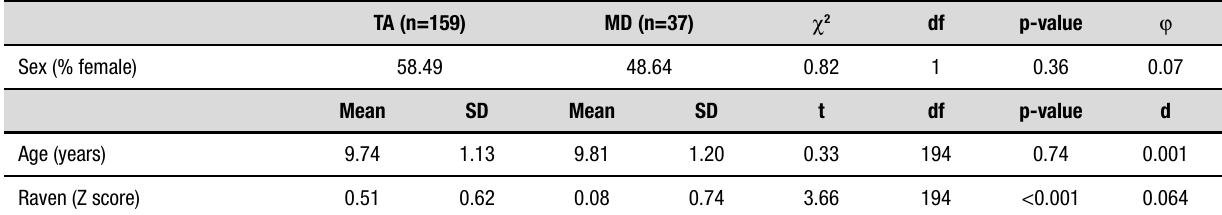
Table 1. Participants’ descriptive